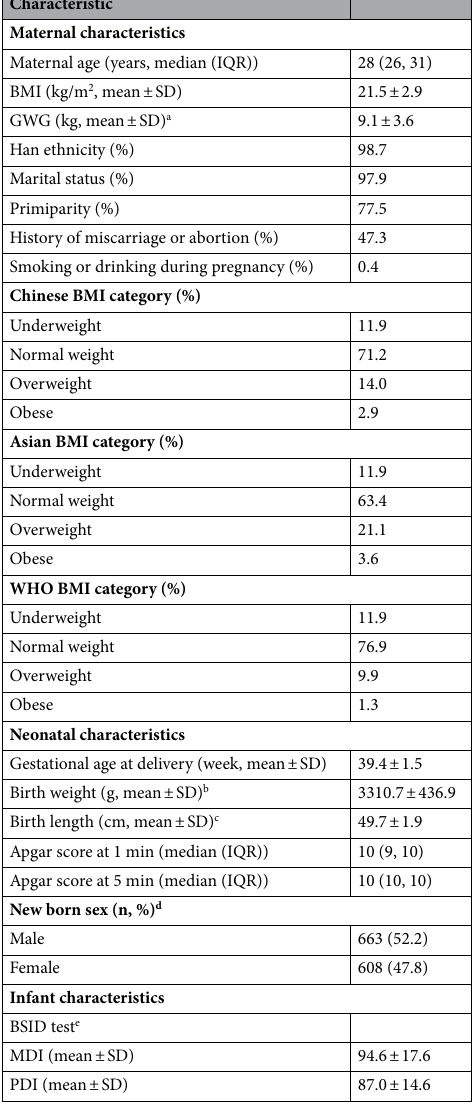
Table 1. Characteristics of the study participants. BMI body mass index, GWG gestational weight gain, BSID Bayley Scales of Infant Development. Values are mean ± SD, median (IQR) or n (%). Missing data: a 77